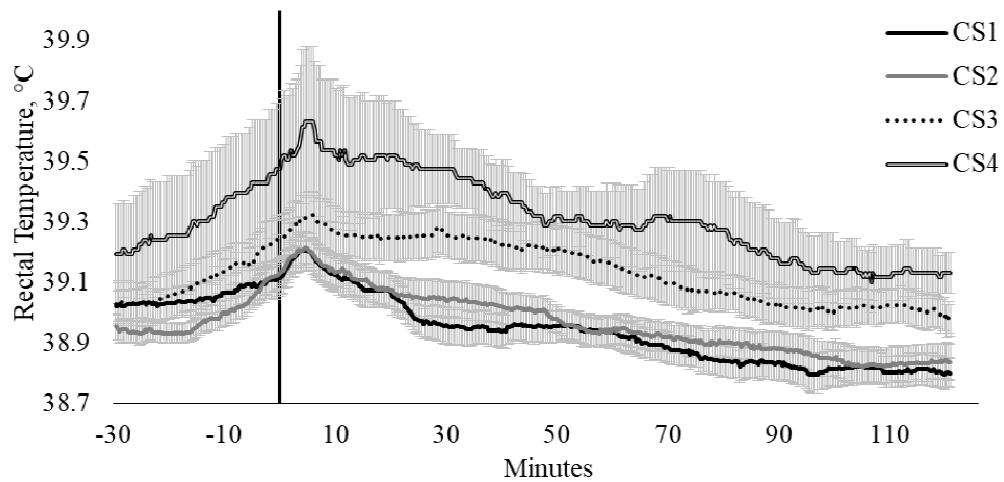
Figure 3. Twenty-seconds mean (±SEM) rectal temperature (T REC , °C) of cattle crush scores (CS) of 1 (CS1; n = 14; ♀ = 4, ♂ = 10); 2 (CS2; n = 16; ♀ = 7, ♂ = 9); 3 (CS3; n = 11; ♀ = 9, ♂ = 2); and 4 (CS4; n = 4; ♀ = 3, ♂ =